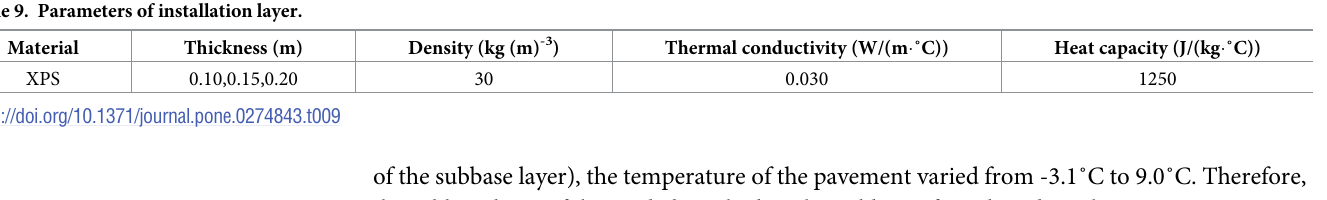
Table 10 showed that the particle size of the subbase layer had almost no effect on the tem- perature of the natural surface center. When the particle size of the subbase layer ranged from 4–6 cm to 10–15 cm, the temperature range of the pavement center decreased at the depth of